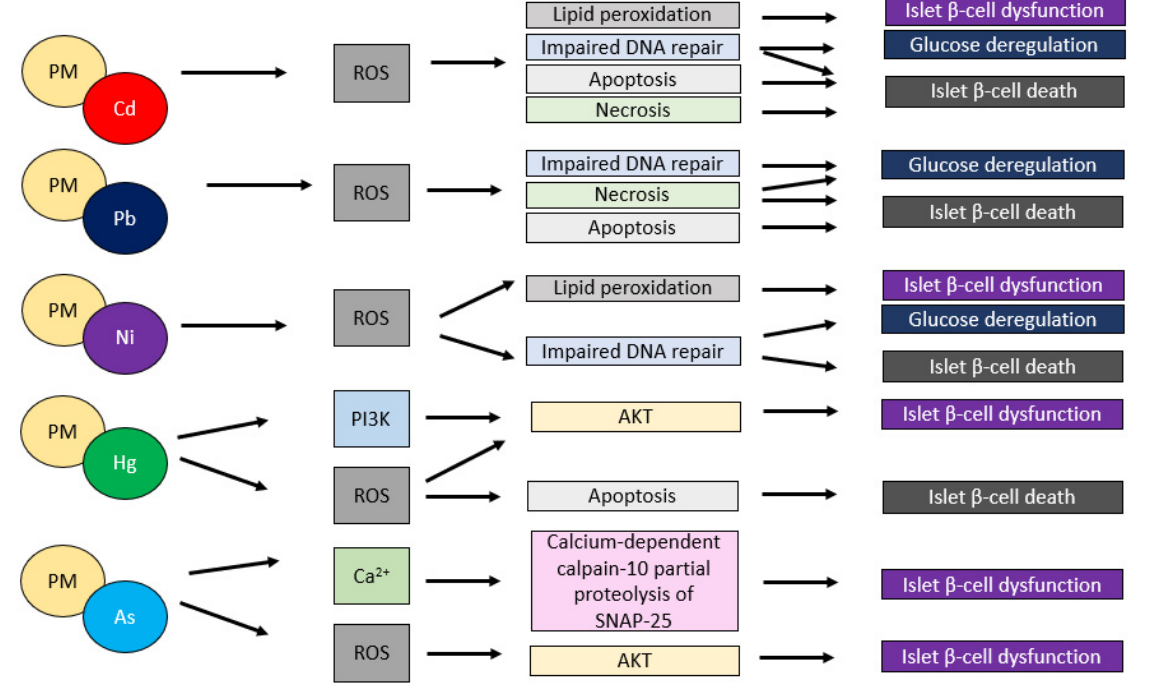
Figure 2. Schematic representation of intracellular signaling leading to PM-adsorbed toxic metals induced β -cell dysfunction. The figure prepared by Marta Jaskulak on the basis of literature